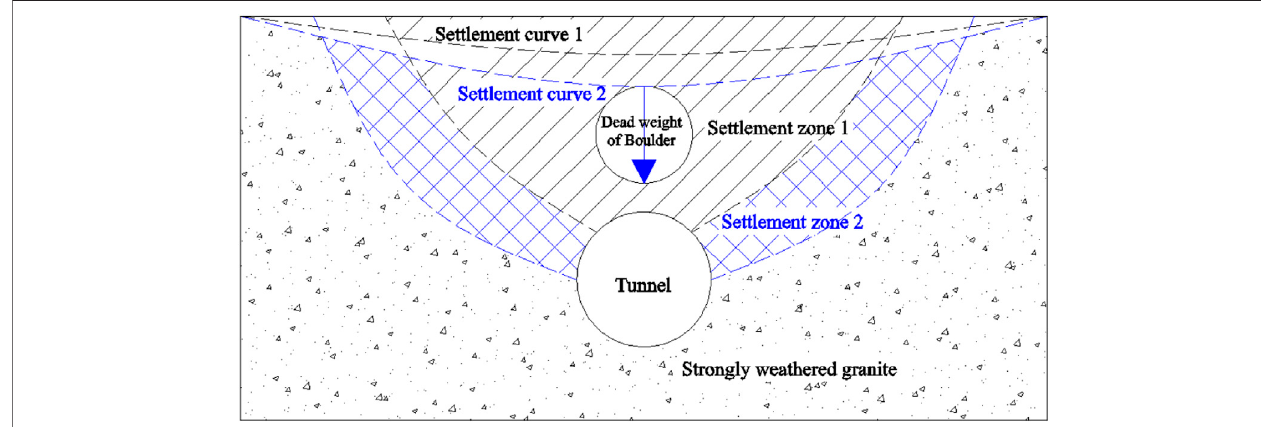
FIGURE 9 | Analysis of weak surface effect of weight loss of boulder under disturbance.